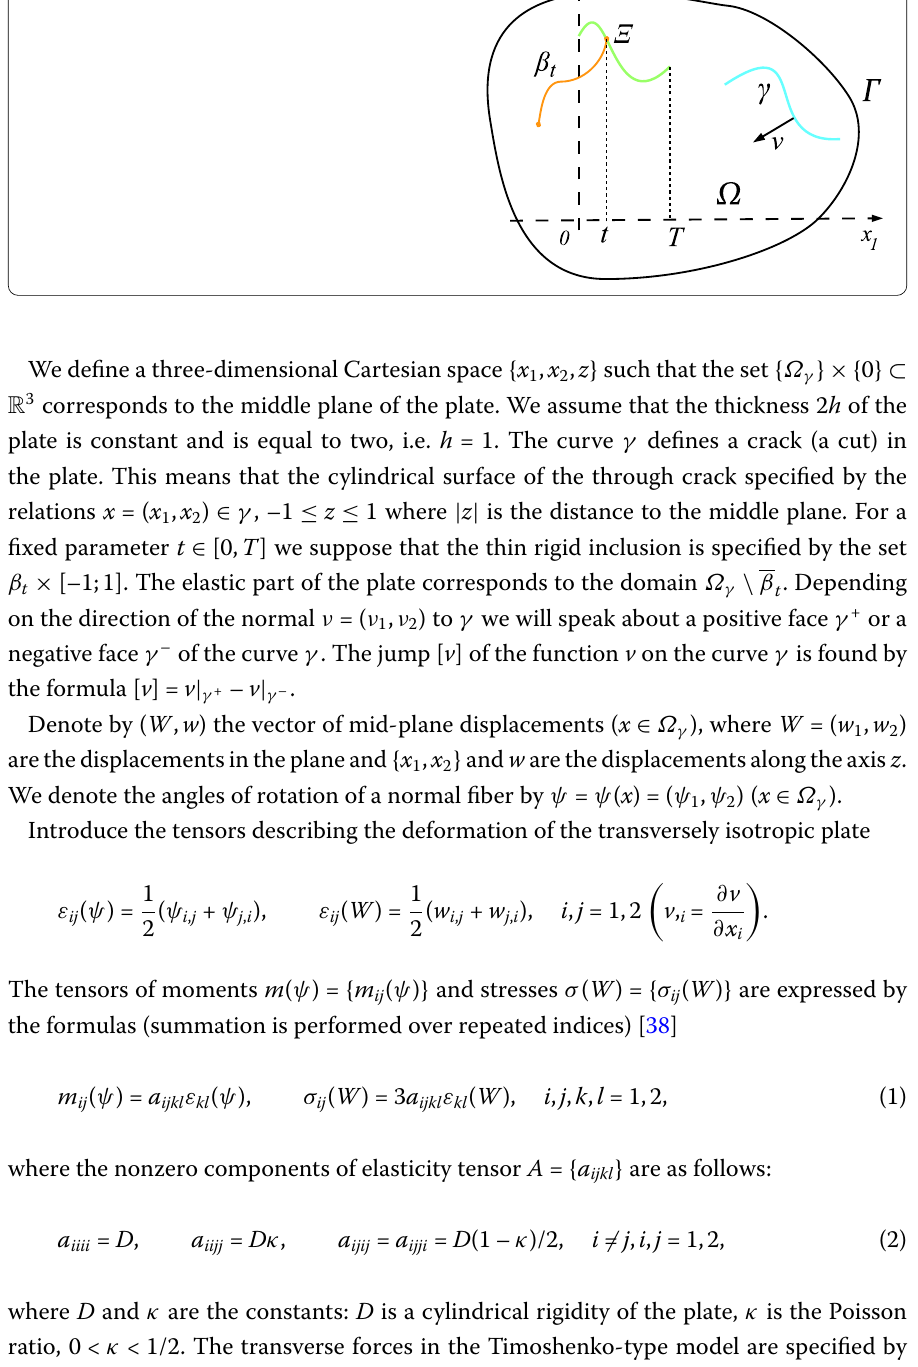
Figure 1 Geometry of the